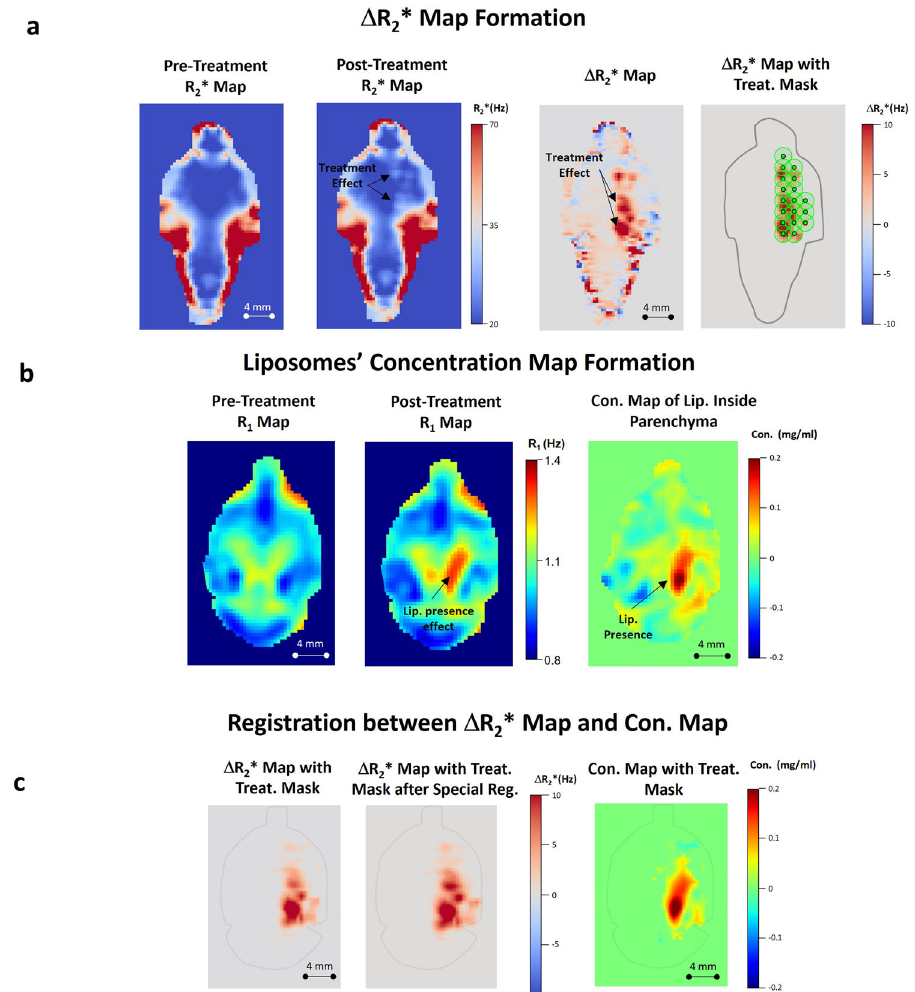
Fig. 3 Analysis fundamentals. a Pre- and post-treatment R 2 * maps (left) and Δ R 2 * map, with and without a treatment mask (right). The white marks in the post-treatment R 2 * map (indicated by arrows) and the red marks in Δ R 2 * maps indicate the treatment-related changes. b Pre- and post-treatment R 1 maps (left) and Gd-liposomal concentration map (right); arrows indicate liposome presence. c Δ R 2 * map with treatment area mask, after registration to the Gd- liposomal concentration map orientation (left). Δ R 2 * map after diffusion mimicking registration to the liposome concentration map (middle); note the Δ R 2 * distribution radial expansion. Gd-liposomal concentration map with treatment area mask